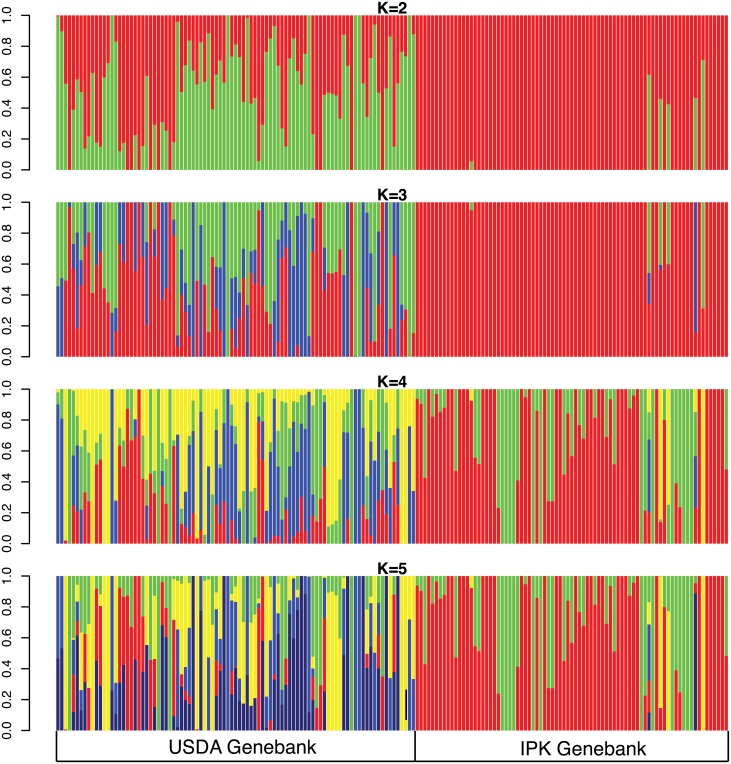
Genetic structure of 174 cauliflower genotypes inferred with ADMIXTURE.The number of predefined clusters ranged from K = 2 − 6 and was inferred using SNPs without missing values (n = 1, 444).